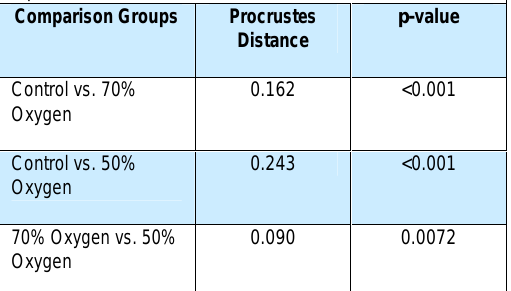
Table 1: Procrustes distances between the mean shapes of each group and their associated p-values as determined by a permutation test